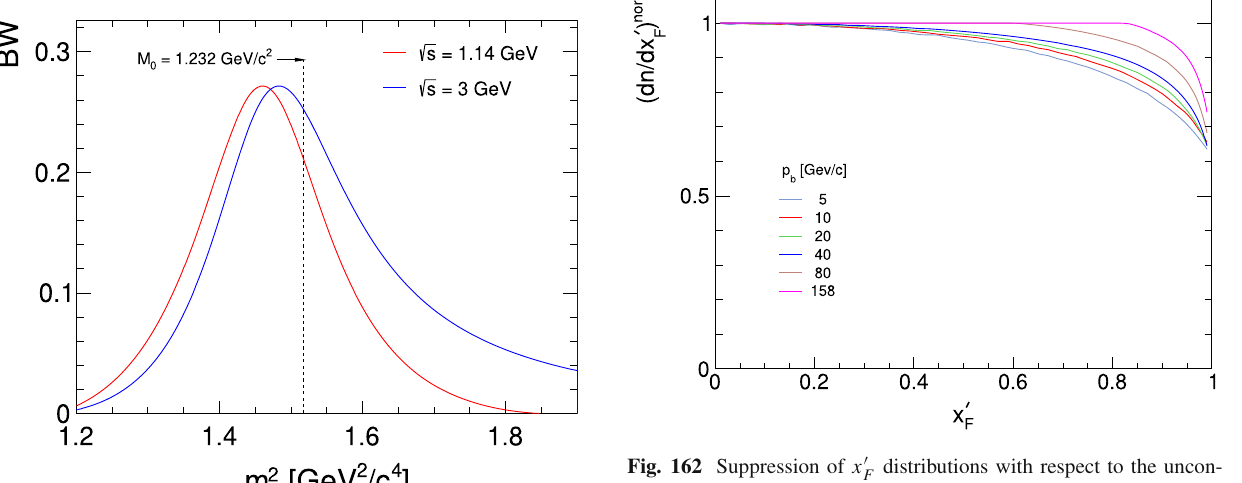
Fig. 162 Suppression of x (cid:3) distributions with respect to the uncon- F strained case for beam momenta between 5 and 158 √ s = 1.86 and 2.61 GeV,